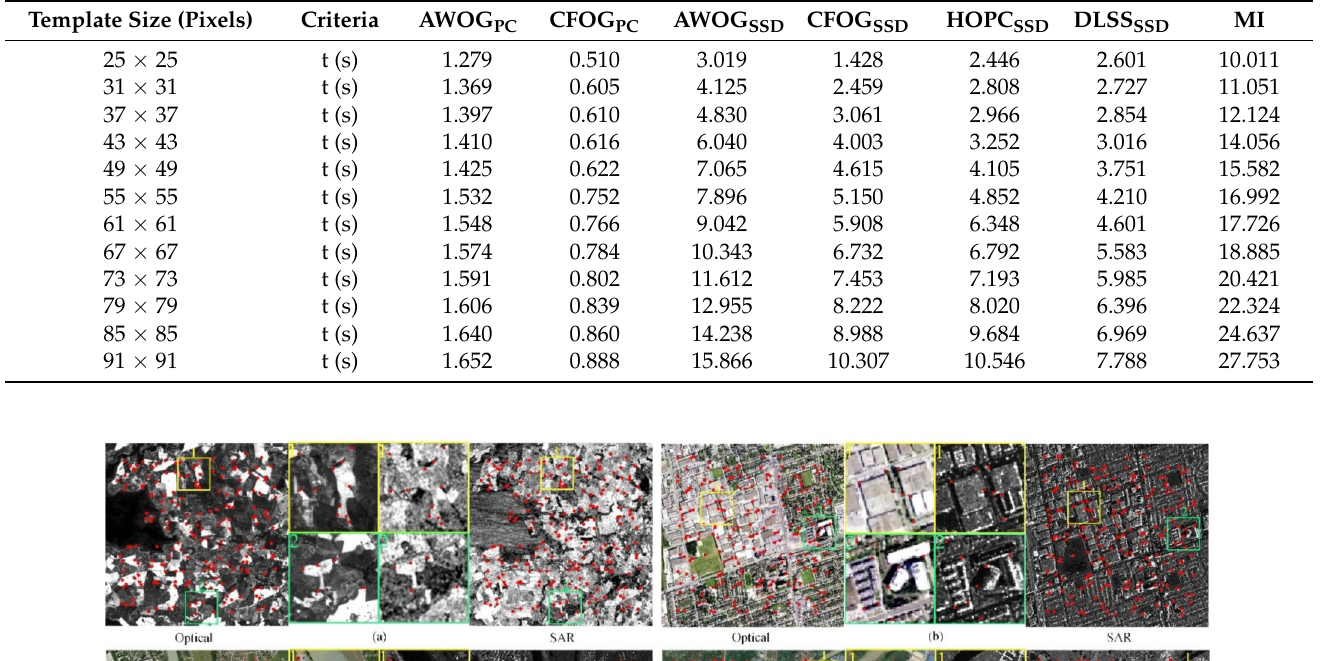
Table 3. The detailed average running times of all methods under different sizes of template windows.